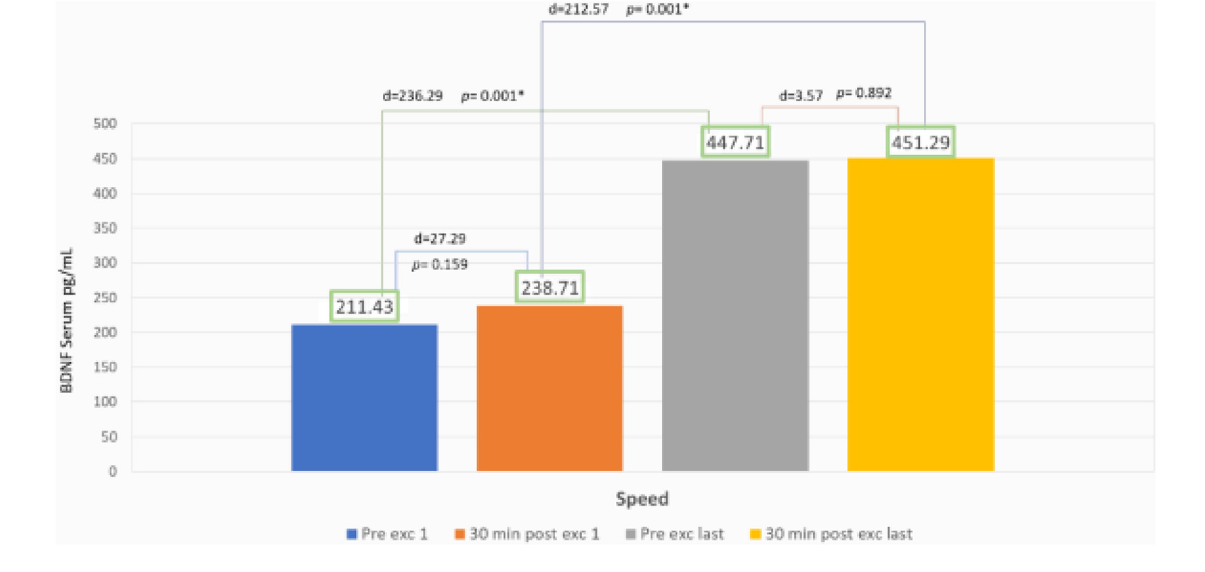
FIGURE 4 | BDNF serum result in speed group.